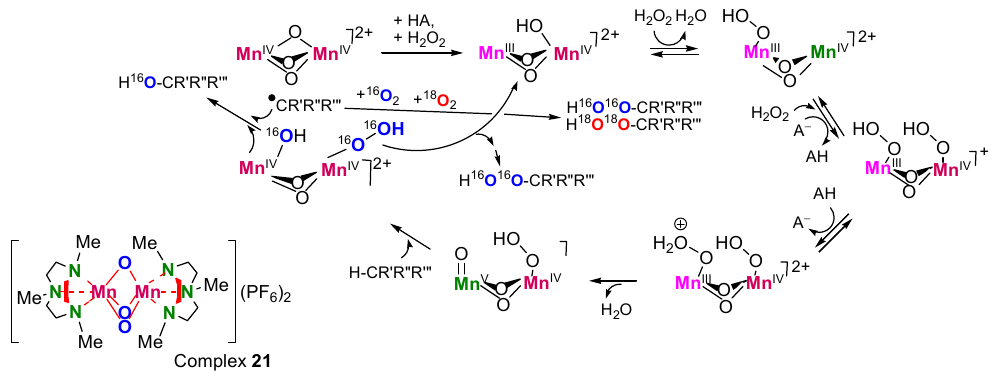
Figure 19. A catalytic cycle proposed for the alkane hydroperoxidation catalyzed by complex 21 in the presence of 18 O 2 (in an atmosphere 16 O 2 + 18 O 2 ). AH is a carboxylic acid where A − is its anion. Adapted from Ref. [283].